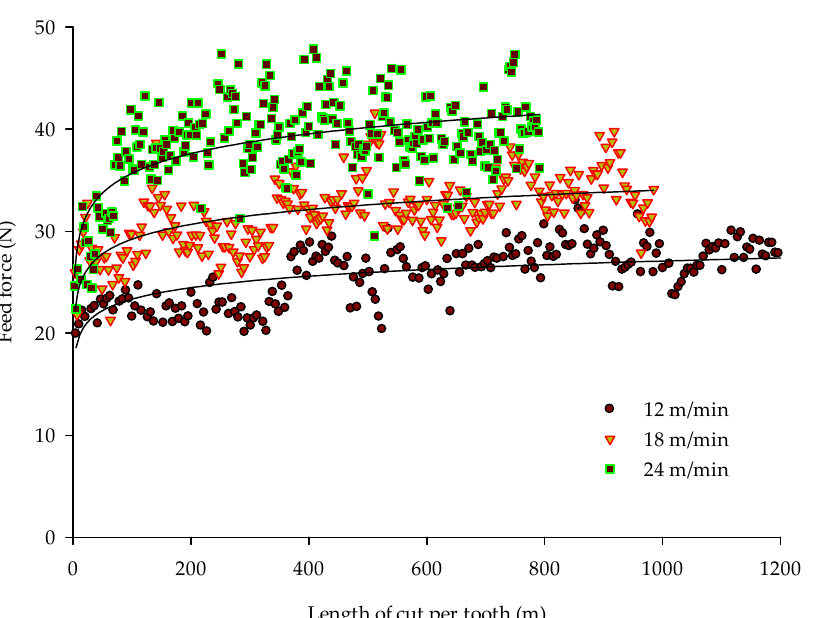
Figure 4. Feed forces for different lengths of cut per tooth.